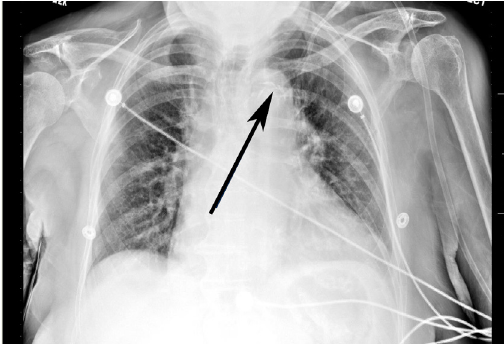
Figure 2 . Egg shell sign (arrow), defined as a distance greater than 6mm from the aortic calcification to the lateral soft tissue margin of the aorta, with a widened mediastinum indicating aortic